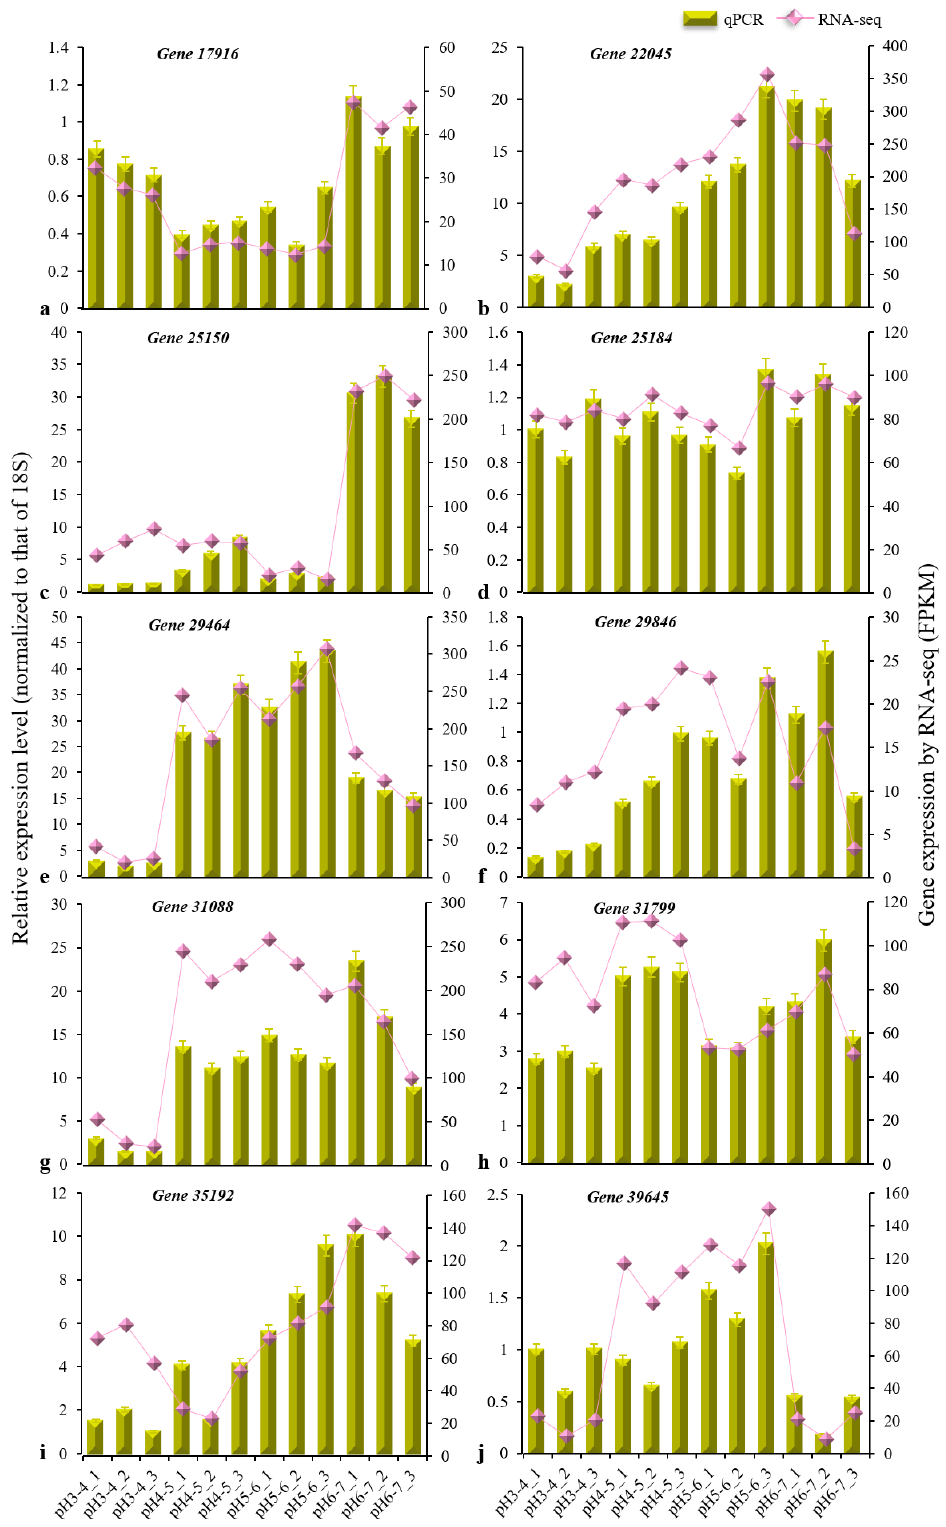
Figure 4. Expression of 10 DEGs ( a – j ) in response to acid stress treatments. The vertical bar charts with simple error bars (left y -axis) represent the quantitation of 10 gene transcripts among twelve samples via qRT-PCR. The values are the means ± SDs ( n = 3). The line and scatter plot (right y -axis) represent the transcript abundance (FPKM) of twelve samples of each gene, as revealed by RNA-seq. The three replicate samples per treatment were treated with soils of pH 3 – 4, 4 – 5, 5 – 6, and 6 – 7.